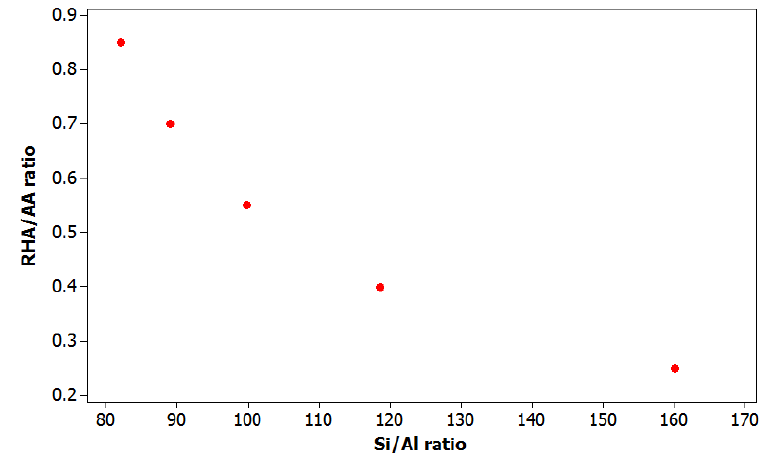
/ AA ratio and Si / Al ratio for adhesion Figure 6. Scatterplot of RHA/AA ratio and Si/Al ratio for adhesion strength. Figure 6. Scatterplot of RHA